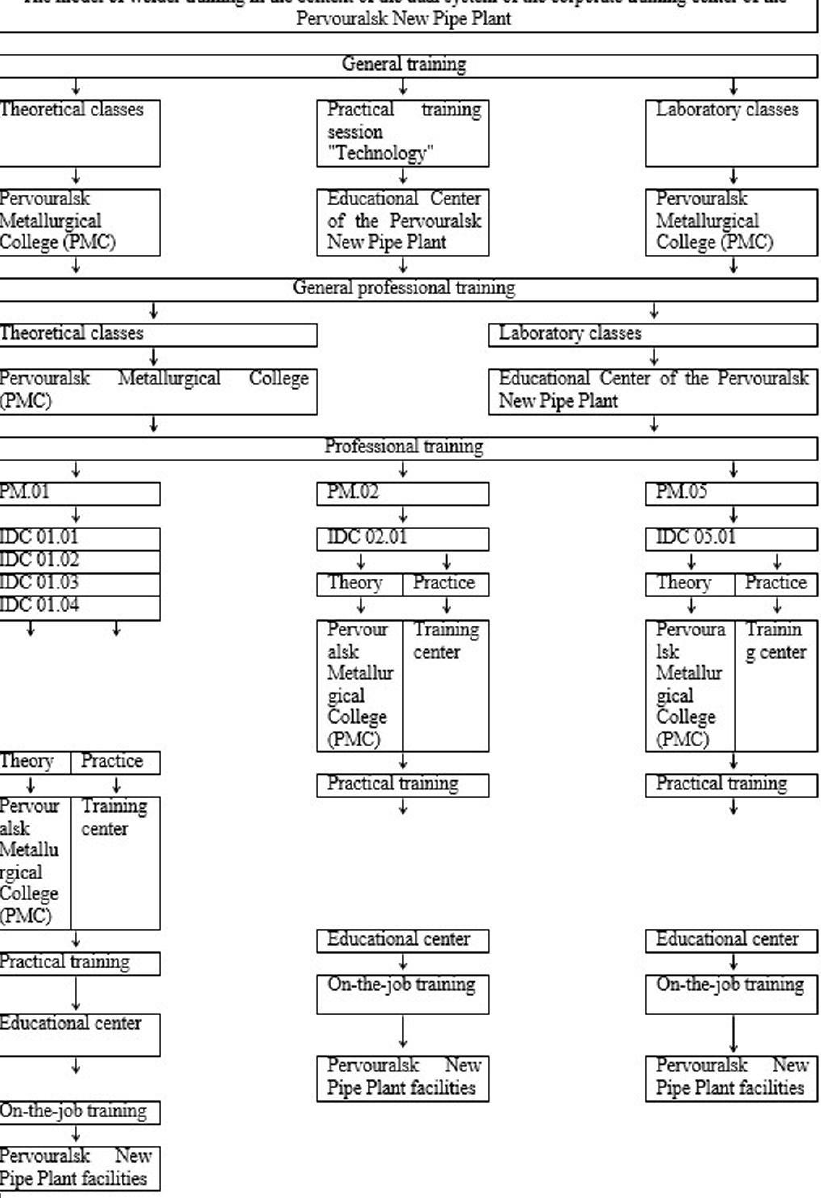
Fig. 1. The model of welder training in the context of the dual system of the corporate training center of the Pervouralsk New Pipe